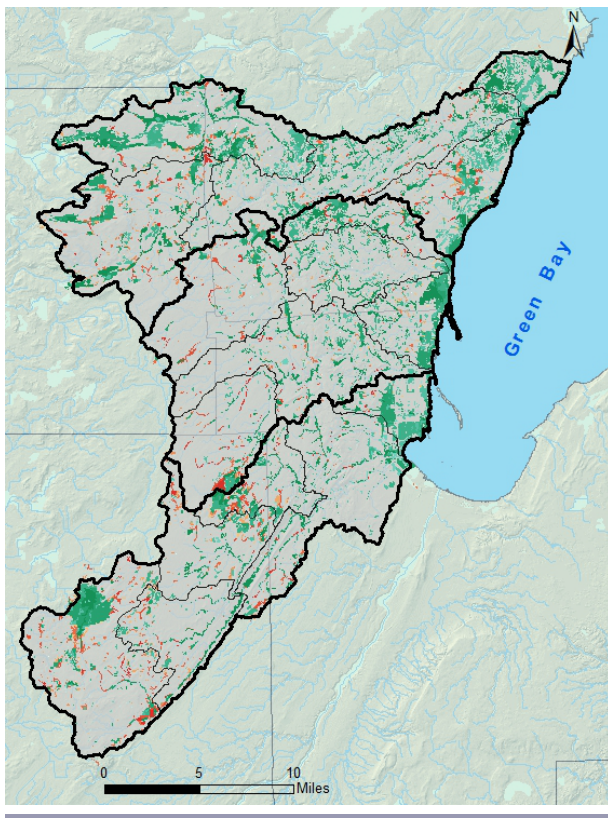
Osenberg 1996). Such potential exists for a large watershed complex along Wisconsin’s Green Bay (Box 1). Fig. 3. Potential for existing wetlands (green shades) and potentially restorable wetlands (red shades) to provide a suite of seven services, including flood abatement, water quality protection, surface water supply, shoreline protection, carbon sequestration, and fish and wildlife habitat. Darker shades indicate greater numbers of services provided at high levels. Map from Miller et al.